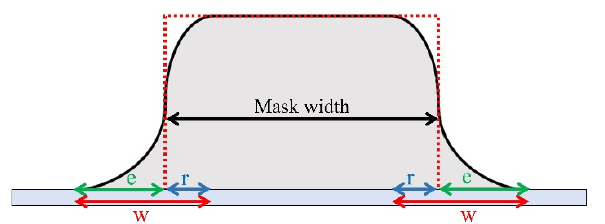
Figure 6. Schematic representation of patterned film height profile obtained with SCBD through a stencil mask, with a non-divergent beam (red dotted line) and with a divergent beam (black continuous line). The cluster beam divergence is responsible for a blurring effect. The lateral sides of the profile rise gradually, with a width w , given by the sum of the enlargement of the mask opening e and the width of the profile that does not reach the maximum height of the film, due to the penumbra effect, r .